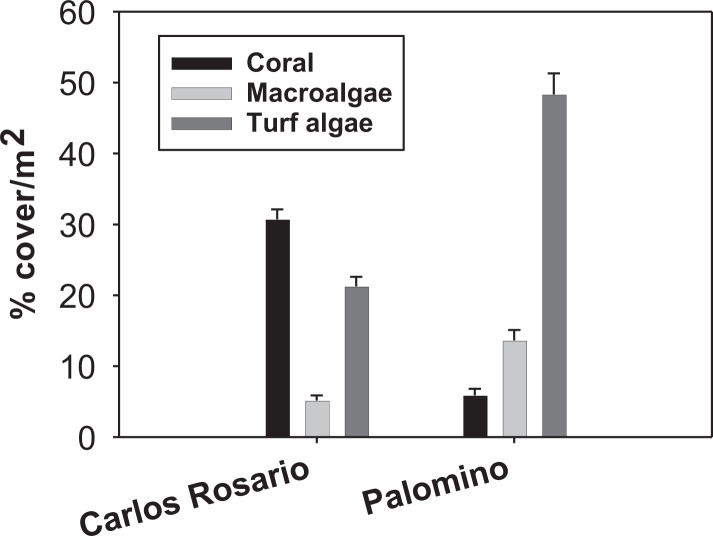
Reef benthic structure of both study sites.